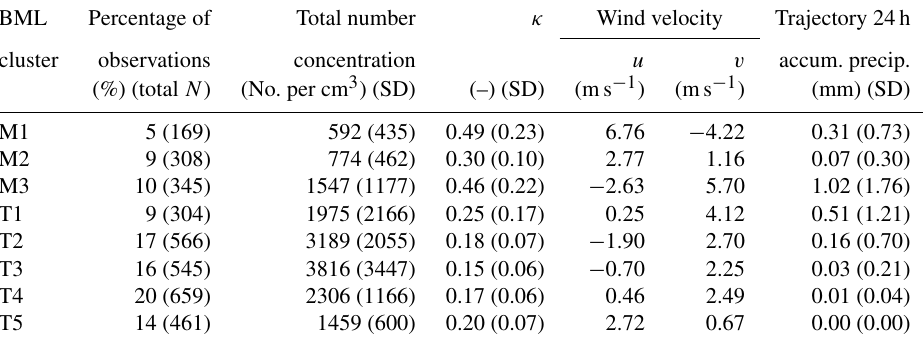
Table 1. Aerosol and meteorological parameters for each of the cluster time periods with the total number and percentage of observations in each cluster. Cluster mean values (and standard deviations where appropriate) are given for total particle number concentration, κ hygroscop- icity parameter from the srCCN system, HYSPLIT 24h accumulated precipitation along the trajectory, and local wind velocity observations. BML Percentage of Total number κ Wind velocity Trajectory 24h cluster observations concentration u v accum. precip. (%) (total N ) (No. per cm 3 ) (SD) (–) (SD) (ms − 1 ) (ms − 1 ) (mm) (SD)